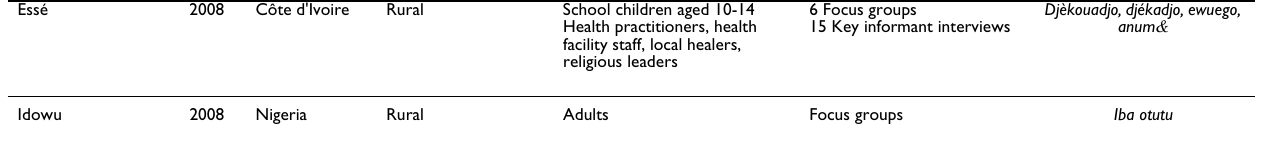
Table 2: Characteristics of qualitative studies in adults and mixed populations